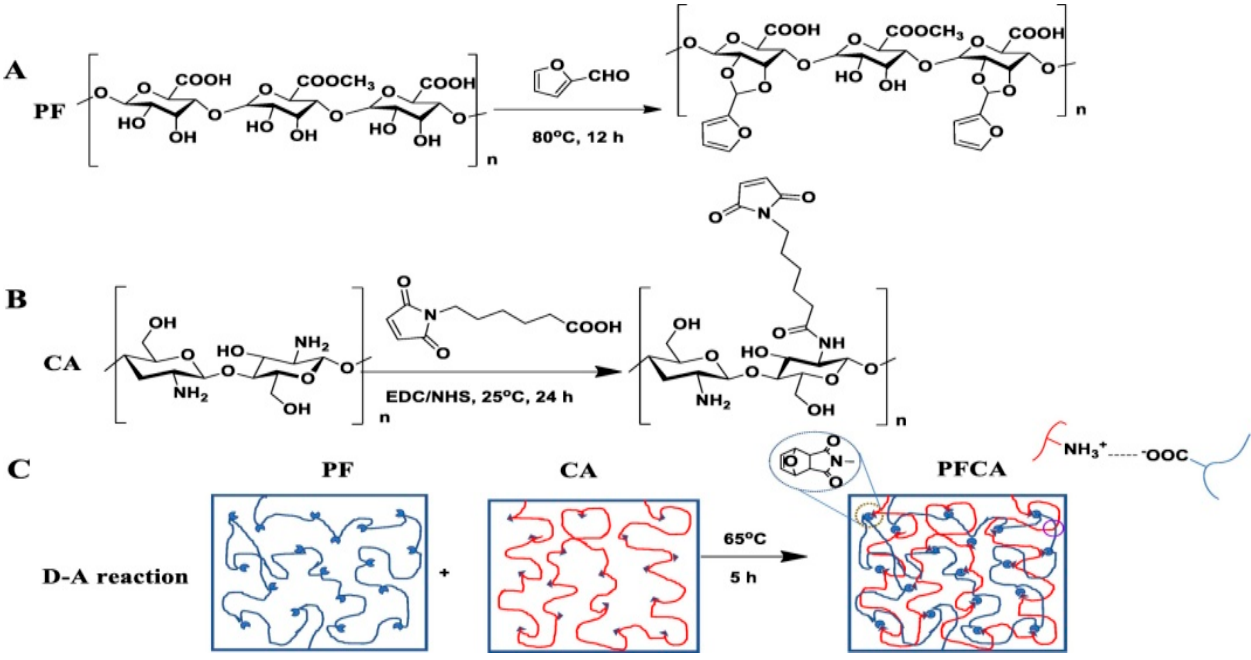
Figure 12. ( A ) modification of pectin with furan, ( B ) modification of chitosan with maleimide, and ( C ) the D-A reaction between furan-modified pectin (PF) and maleimide-modified chitosan (CA) forming in situ hydrogel (adapted with permission from Le et al., 2021).